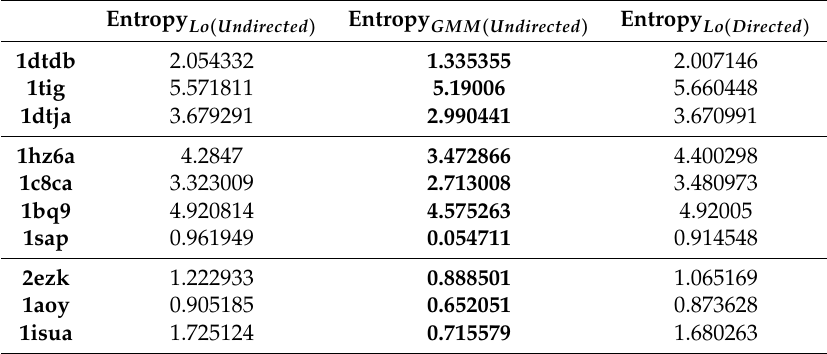
Table 8. Entropy values for the Louvain and GMM